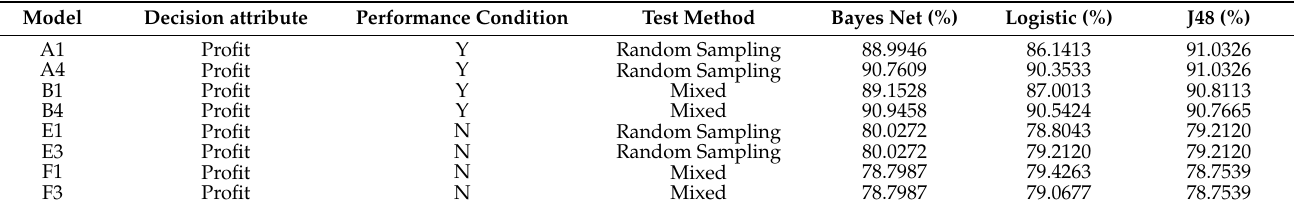
Table 8. Statistical table of profit as decision attribute.